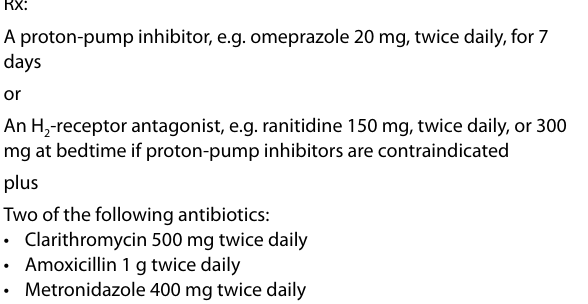
Table 5: Recommended seven-day regimen for the eradication of Helicobacter pylori 18